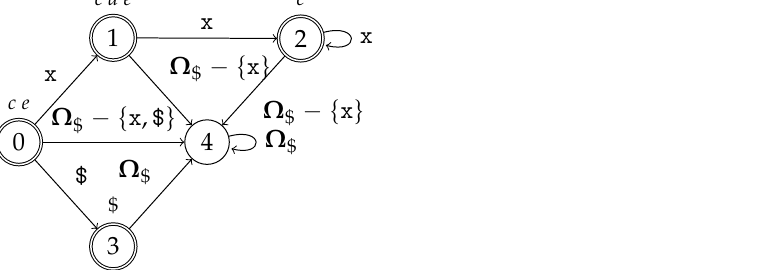
Figure 16. The scanner automaton 9 M T